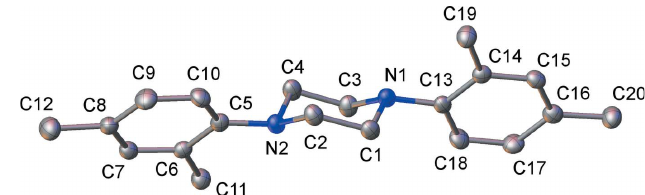
Figure 1 Displacement ellipsoid plot (50% probability) of the asymmetric unit of compound 1